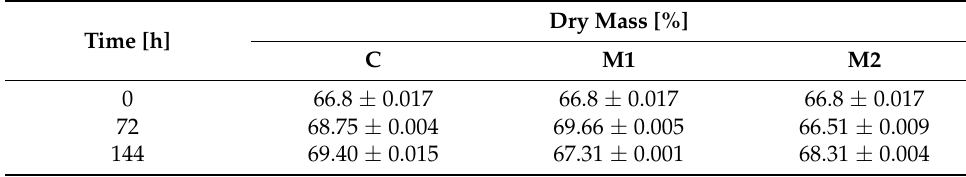
Table 1. The dry mass of sliced chicken